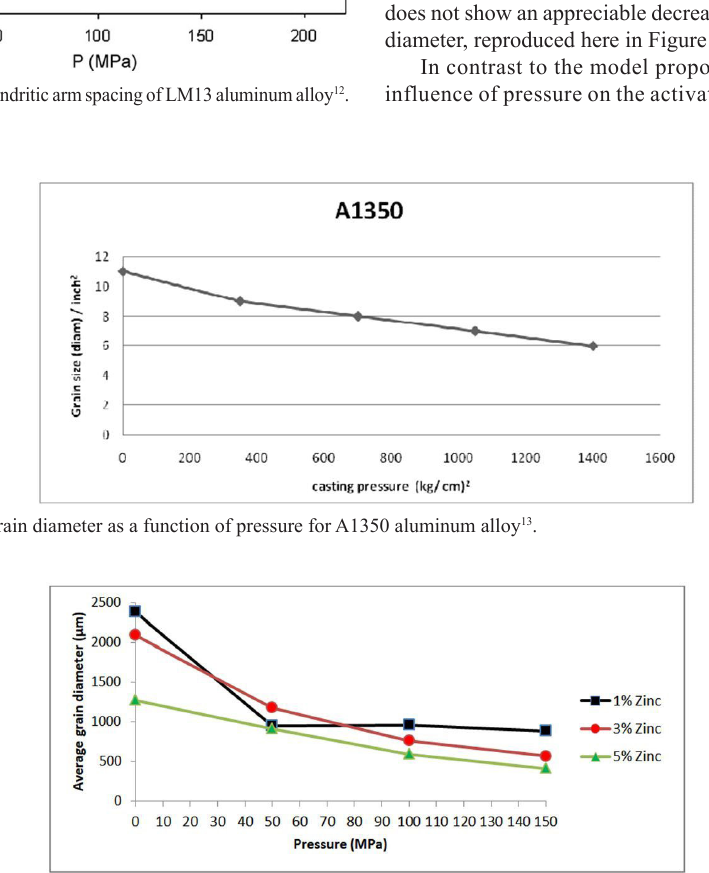
Figure 11. Average grain diameter versus pressure for aluminum alloys Al-Zn 1%, Al-Zn 3% and Al-Zn 5% 14